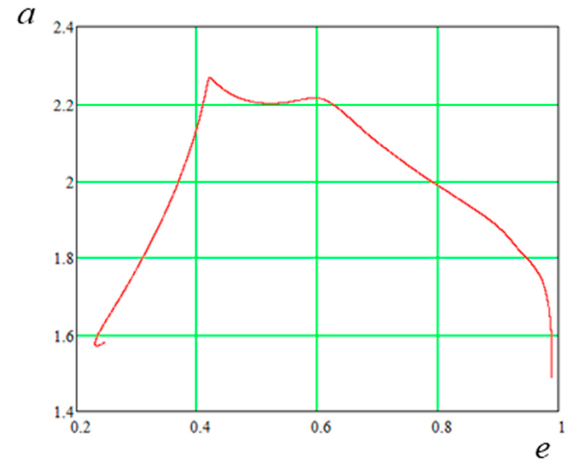
Figure 10. Plane of changing the parameters “Eccentricity—semi-major axis” [undim.].